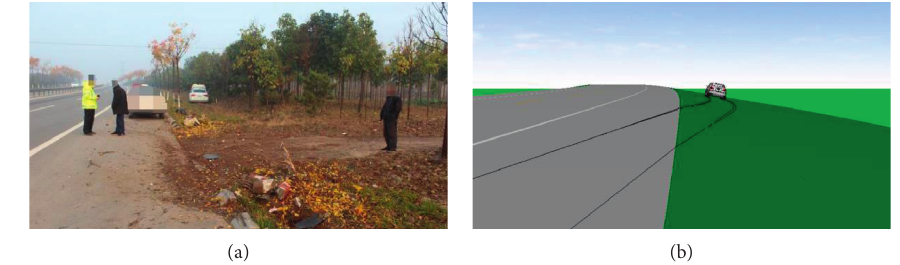
Figure 3: Simulation calibration: (a) accident scene and (b) simulation